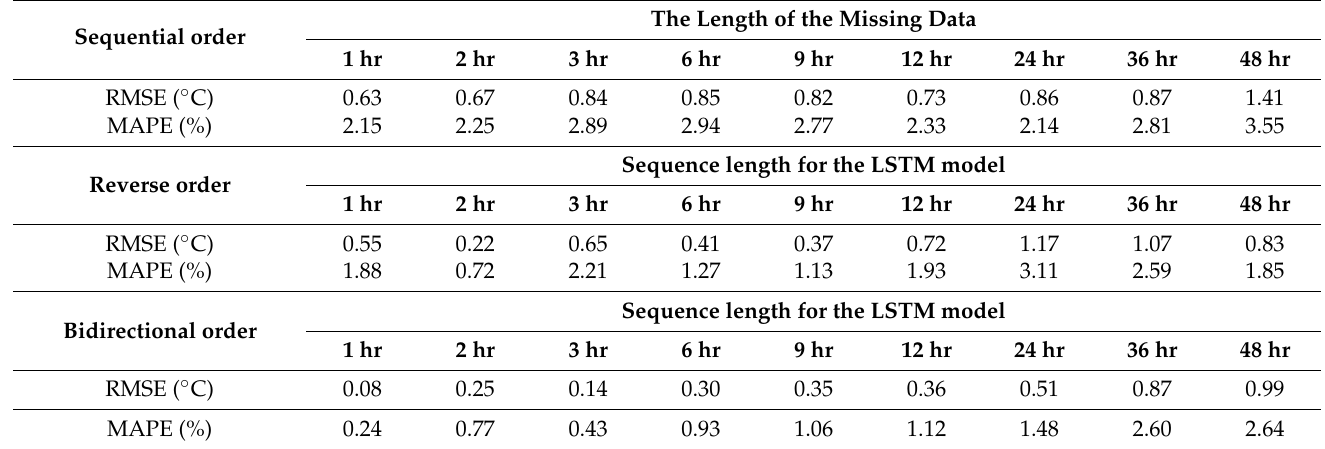
Table 6. The RNN model’s accuracy, according to the order of learning data and the length of the missing